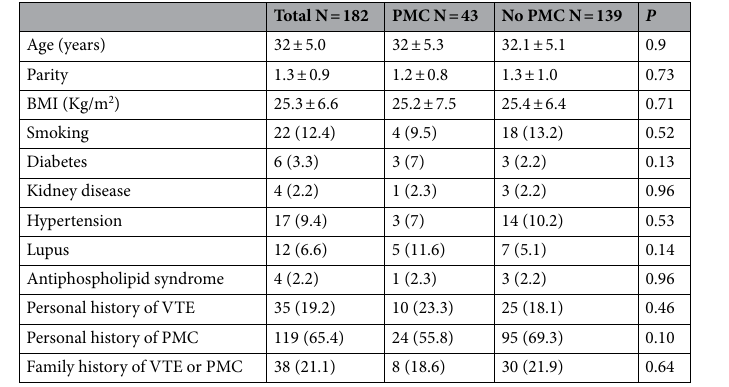
Table 1. Patient characteristics at inclusion. Categorical variables reported as frequency (percentage) and continuous variables reported as mean ± standard deviation. BMI body mass index, VTE venous thromboembolism, PMC Placenta-mediated